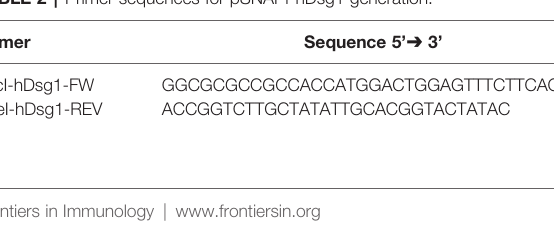
TABLE 2 | Primer sequences for pSNAPf-hDsg1